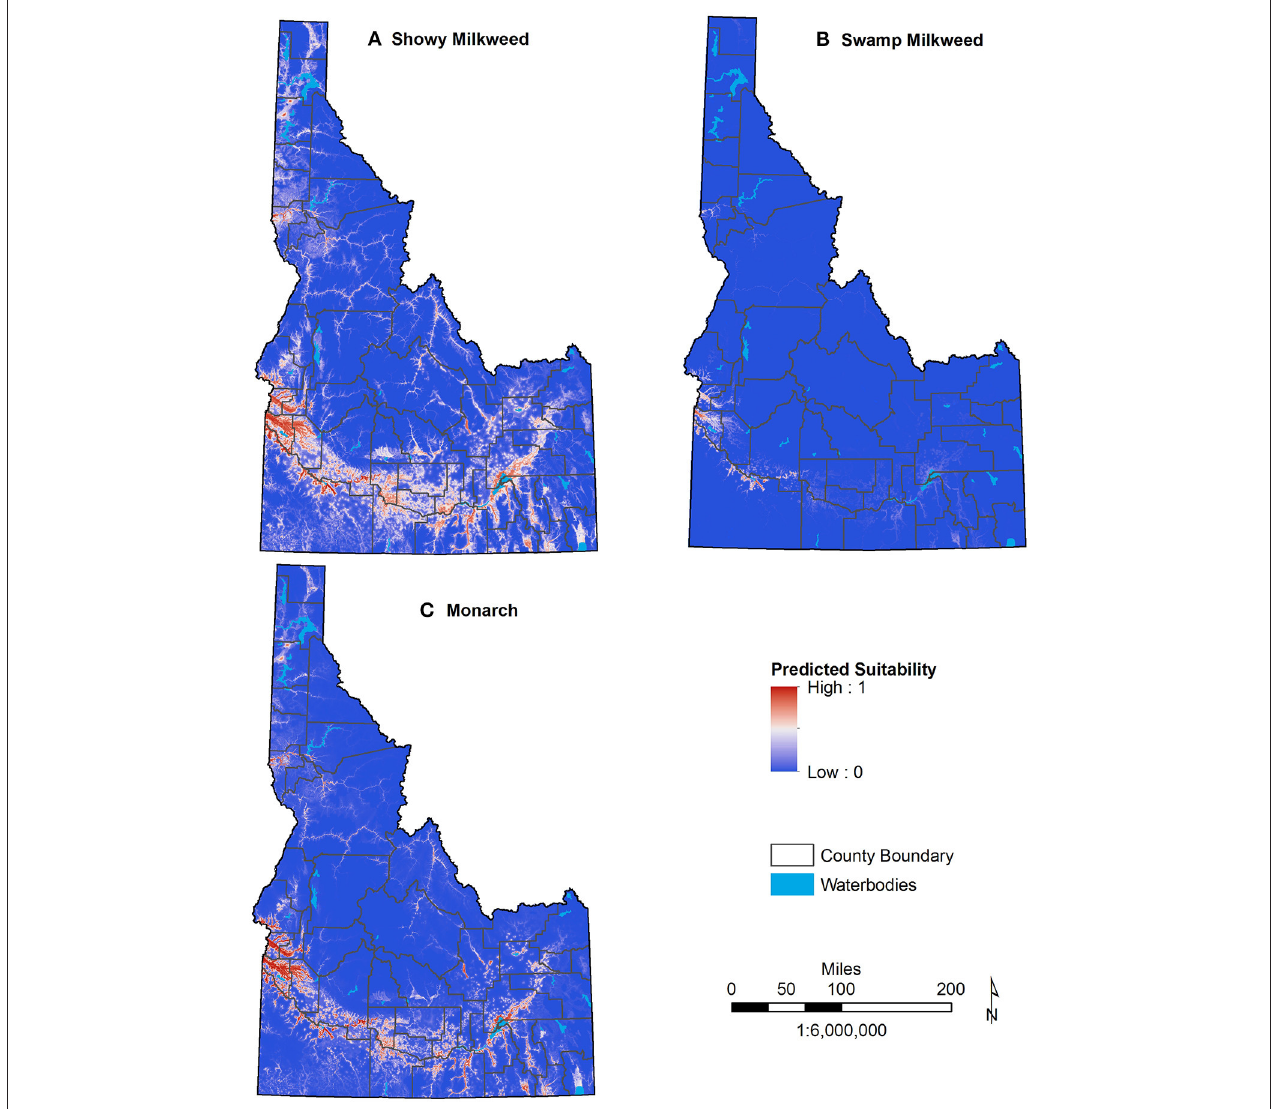
FIGURE 2 | Current predicted distributions of showy milkweed (A) , swamp milkweed (B) , and monarch butterfly (C) across Idaho. Areas of higher suitability are shown in red with lower suitability in blue.